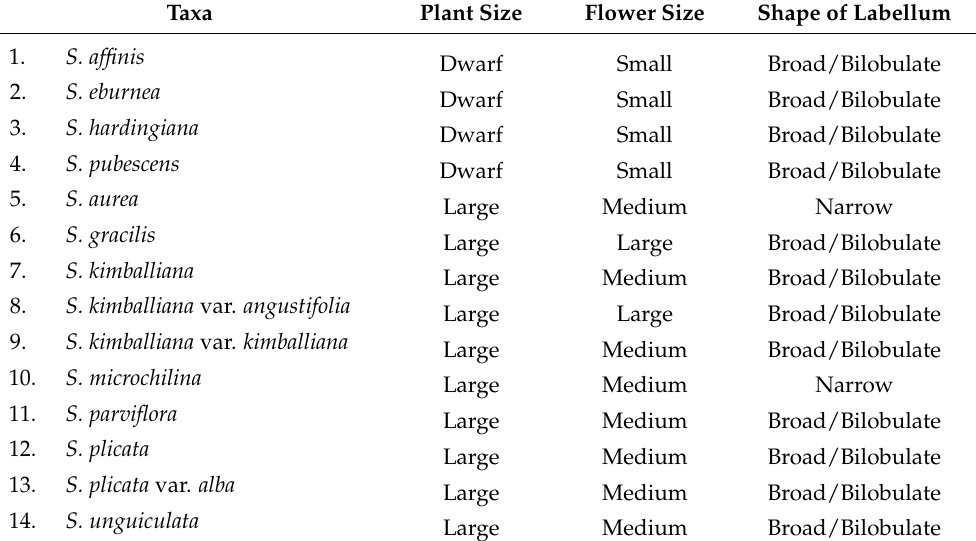
Table 3. The 11 species and three infraspecific taxa of Spathoglottis grouped based on the plant sizes (Dwarf Spathoglottis = ≤ 30 cm tall and Large Spathoglottis = ≥ 30 cm up to 2 m tall), flower sizes (small–sized = 3.0 cm cross, medium–sized = 3.0–4.0 cm cross and large–sized = >5.0 cm cross) and shape of labellum (narrow or broad/bilobulate). Taxa Plant Size Flower